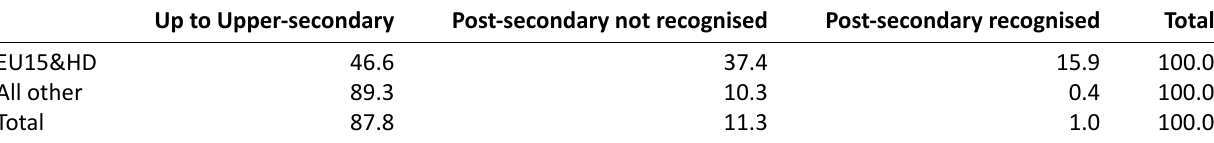
Table A2. Descriptive statistics for the interaction term in Figure 2 (area of origin ## education at origin).